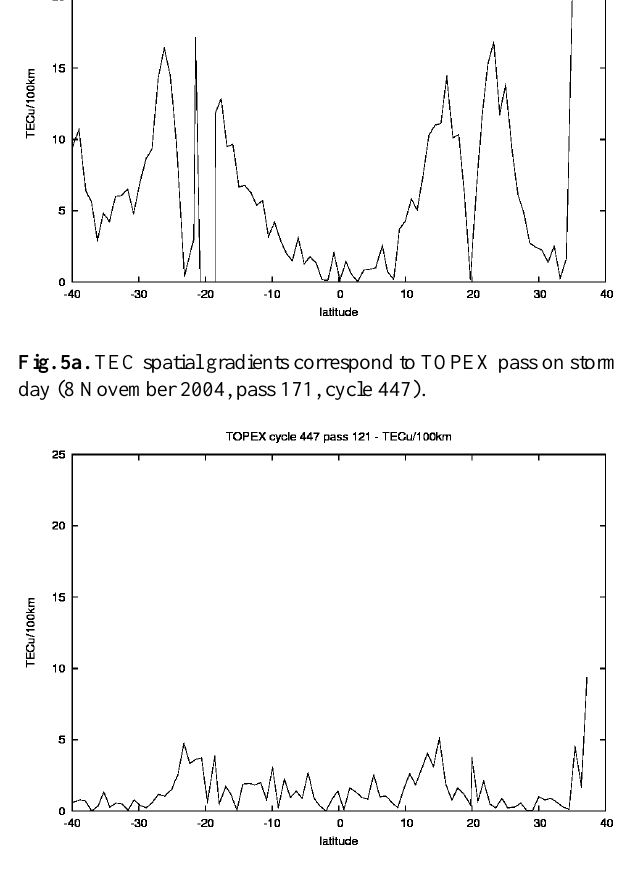
Fig. 5b. TEC spatial gradients correspond to TOPEX pass on a quiet prestorm day (6 November 2004, pass 121, cycle 447)